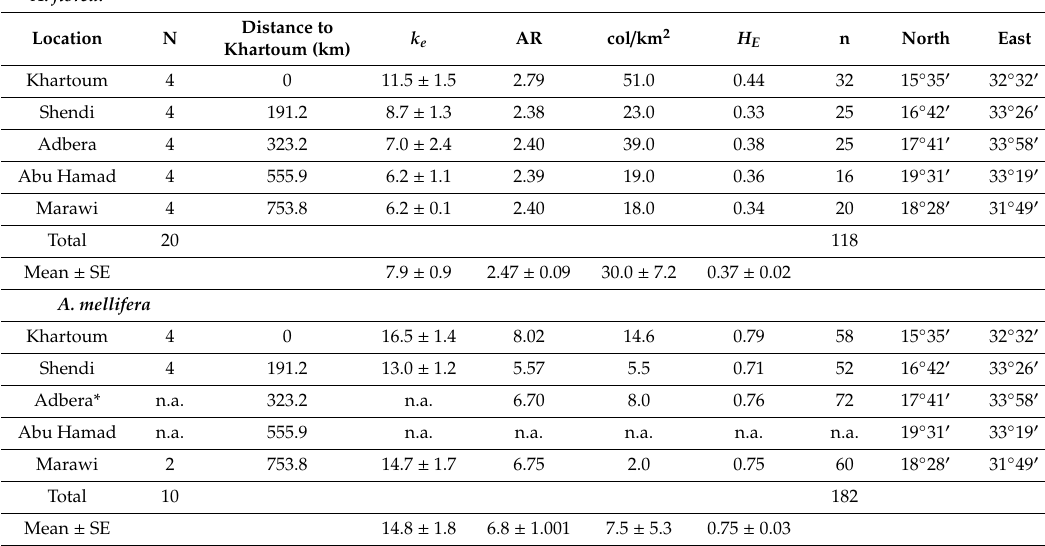
Table 1. Genetic structure of the sampled A. florea and A. mellifera populations. N = number of colonies. k e = estimated number of matings, AR = allelic richness, col / km 2 = colony density, H E = expected heterozygosity, n = number drones inferred from worker sample, * physical drone samples on DCA (ke not applicable).